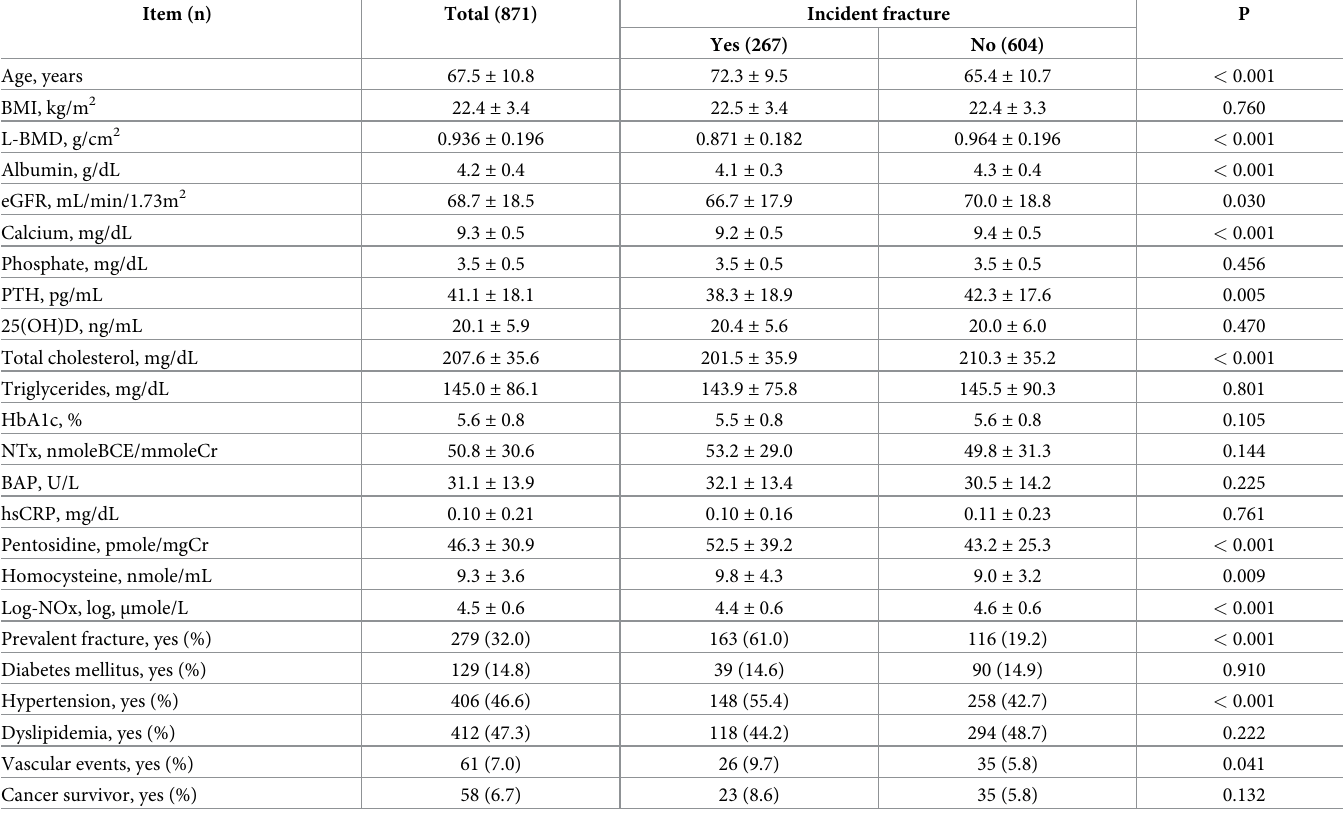
Table 1. Baseline data of total subjects and subjects with or without incident osteoporotic fractures.